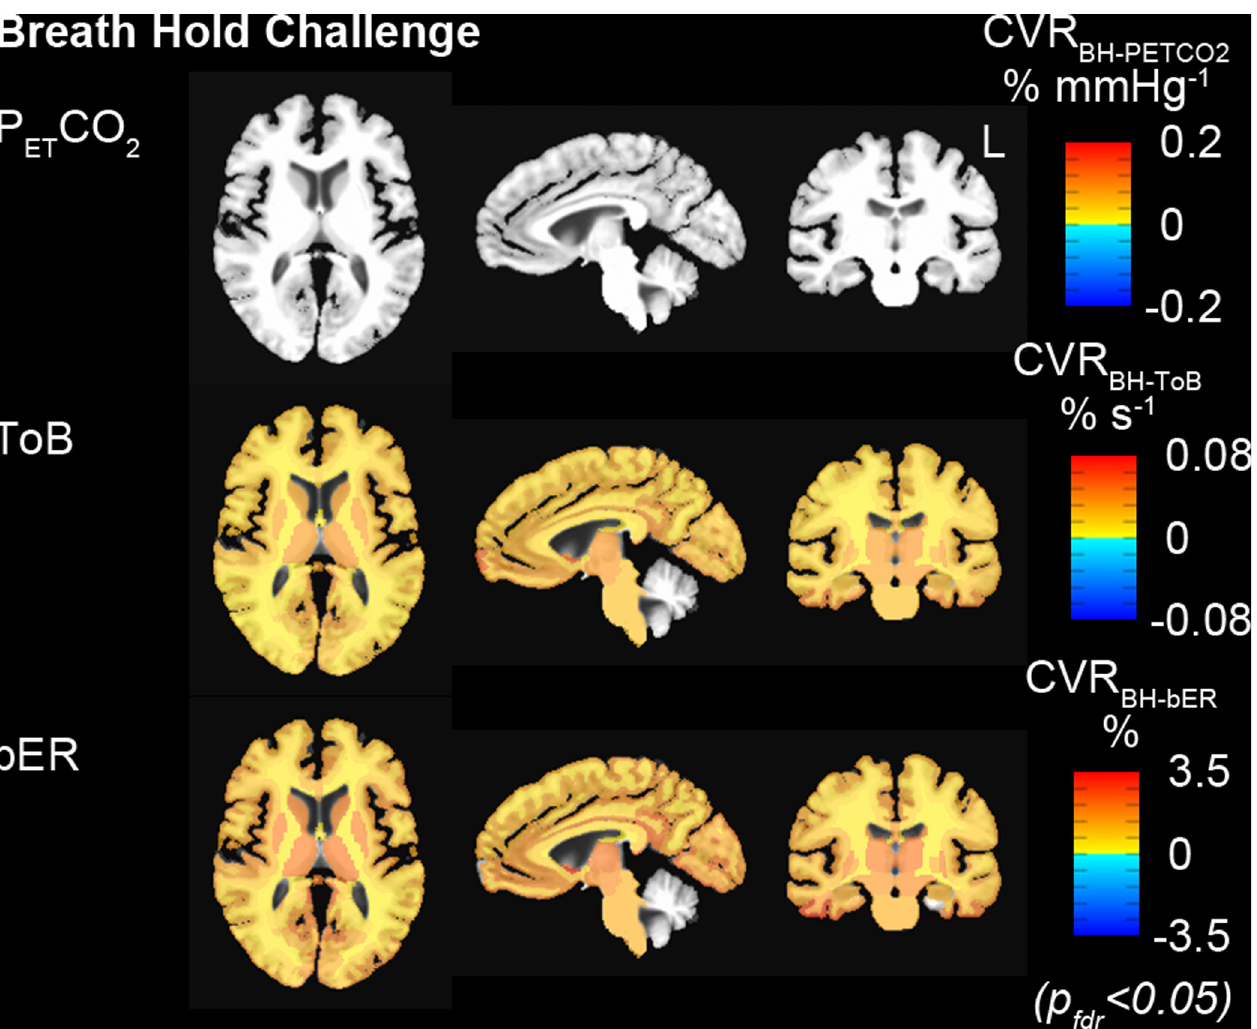
Fig 4. Group CVR maps (CVR BH-PETCO2 , CVR BH-ToB and CVR BH-bER ) generated by regressing Δ BOLD separately on P ET CO 2 , ToB and bER under breath hold challenges (n = 16). All the CVR maps had been corrected for p fdr < 0.05. Maps of CVR BH-ToB and CVR BH-bER were comparable, while P ET CO 2 was not able to characterize the regional Δ